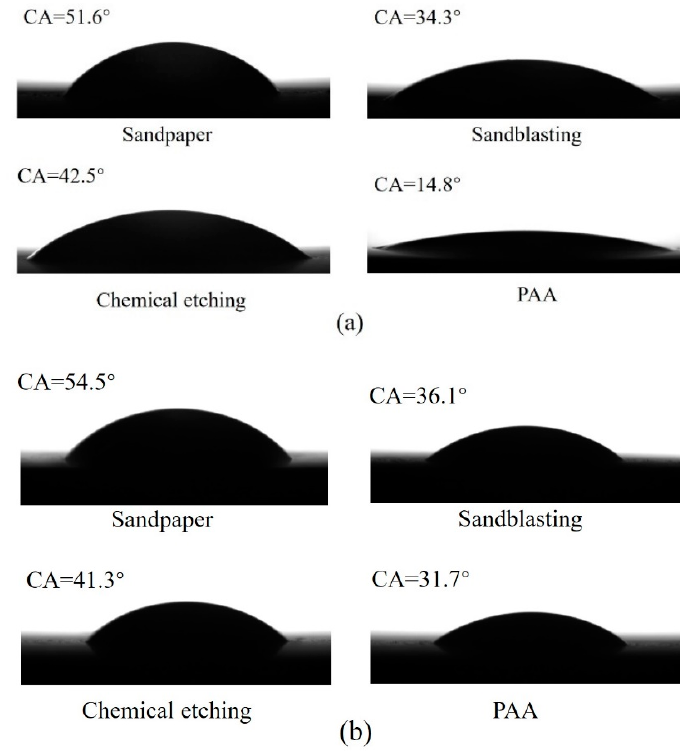
Figure 4. Contact angles on different treated surfaces of ( a ) deionized water and ( b ) FM 94 adhesive.